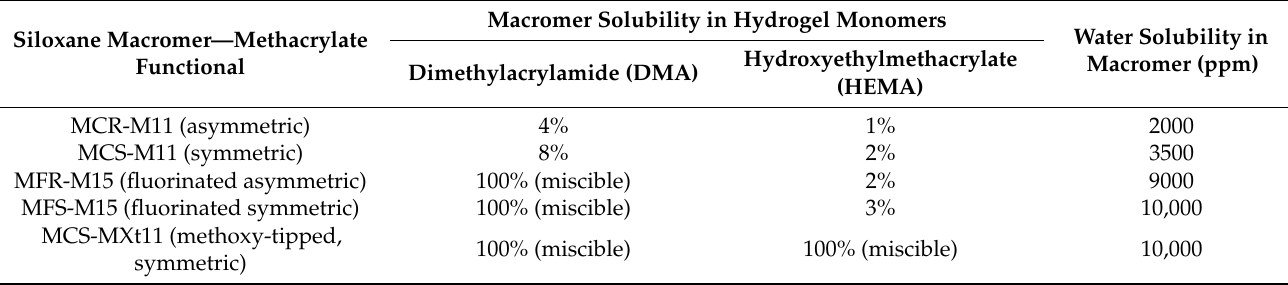
Table 6. Solubility of Methacrylate Functional Silicone Macromers